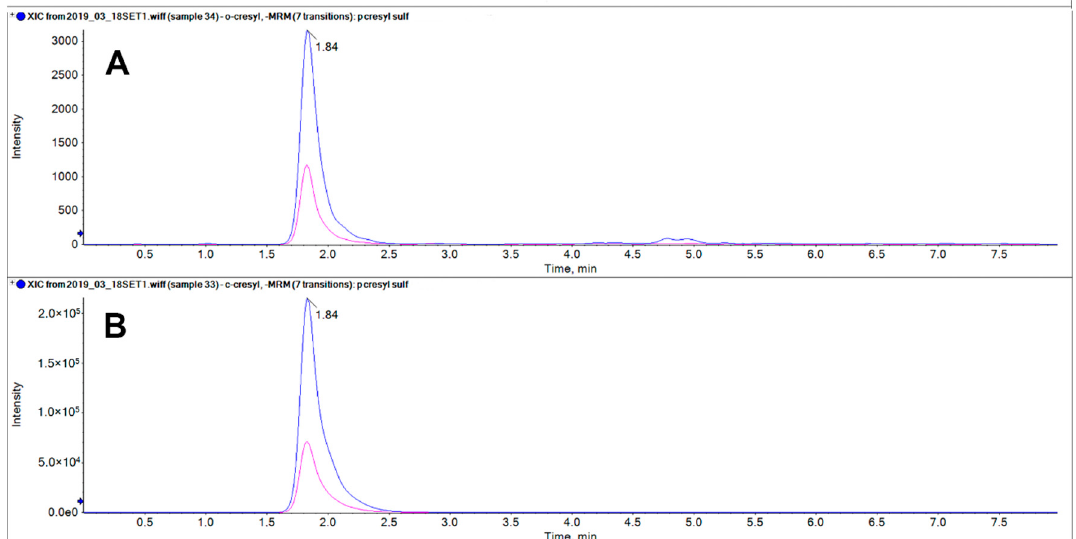
Figure 6. LC-MS/MS analysis of 25 μ M p CS ( 1 , A ) and 25 μ M 2-hydroxy-5-methylbenzenesulfonic Figure 6. LC-MS / MS analysis of 25 µ M p CS ( 1 , A ) and 25 µ M 2-hydroxy-5-methylbenzenesulfonic acid ( 2 , B ). The pink and the blue transition correspond respectively to m/z 187.1 > 80 and 187.1 > 107. acid ( 2 , B ). The pink and the blue transition correspond respectively to m / z 187.1 > 80 and 187.1 > 107. The ion yield of isomer B is close to 100-fold-higher than that of isomer A. The ion yield of isomer B is close to 100-fold-higher than that of isomer